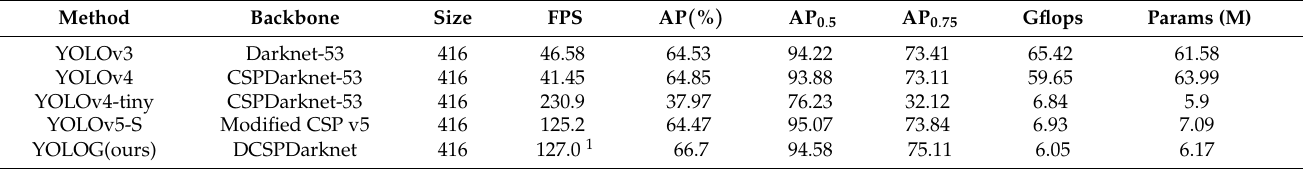
Table 4. Comparison of the speed and accuracy of different object detectors on the garbage data set. The FPS values in this table were measured without post-processing in the Jetson NV AGX Xavier.